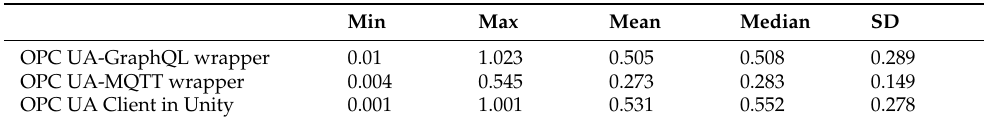
Table 4. The response times in seconds for the different communication middleware. SD = standard deviation. Min Max Mean Median SD OPC UA-GraphQL wrapper 0.01 1.023